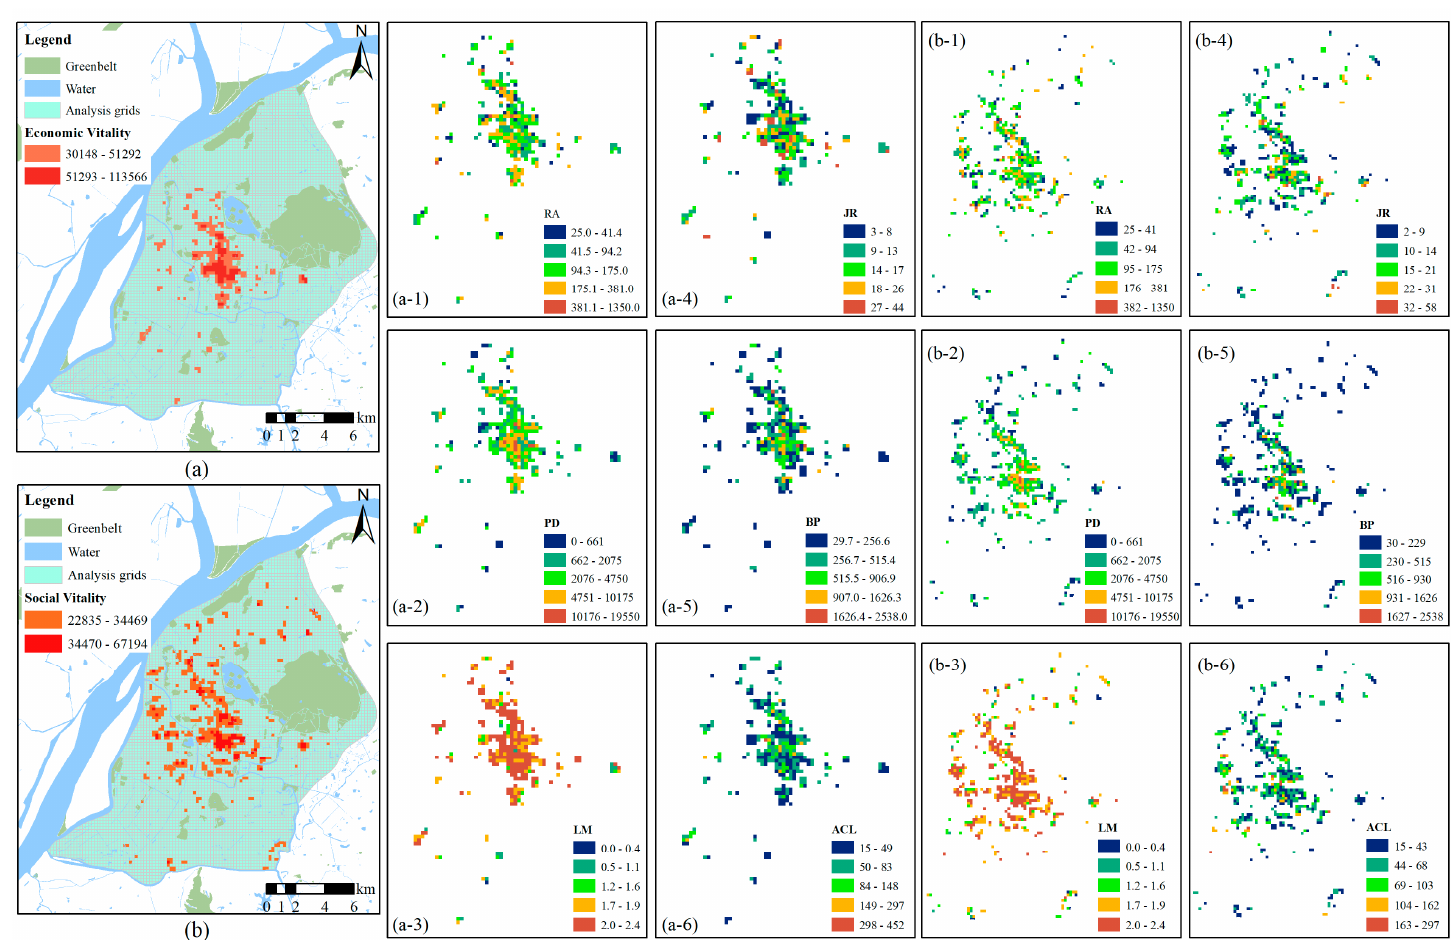
Figure 8. Spatial distribution of driving indicators values of high vitality areas in the study area. ( a , b ) are the spatial distribution of high urban economic vitality and high urban social vitality areas, respectively. ( a-1 to a-6 ) are the hierarchical distribution of driving indicators in high economic vitality areas, and ( b-1 to b-6 ) are the hierarchical distribution of driving indicators in high social vitality areas.